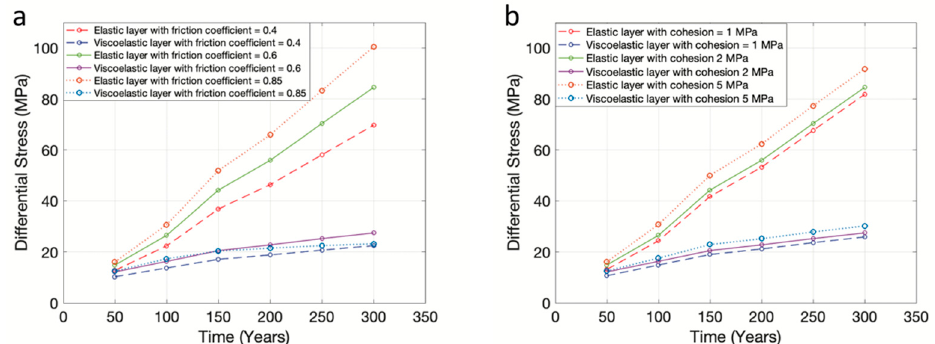
Figure 7. Differential stress at the boundary of each layer of strain buildup model based on ( a ) different friction coefficient and ( b ) different cohesion.